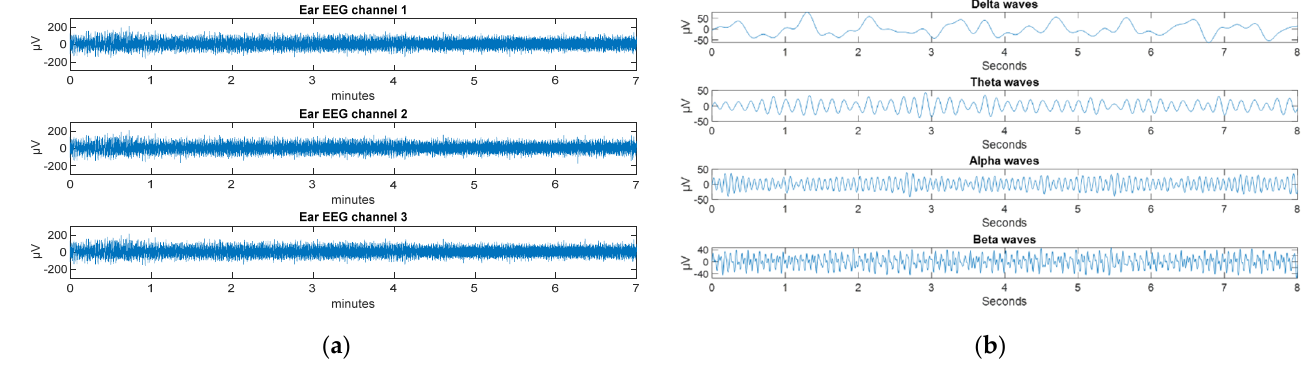
Figure 9. ( a ) Each of the filtered channels of the ear EEG signal; ( b ) Different waves that make up a channel of the EEG signal from the ear.